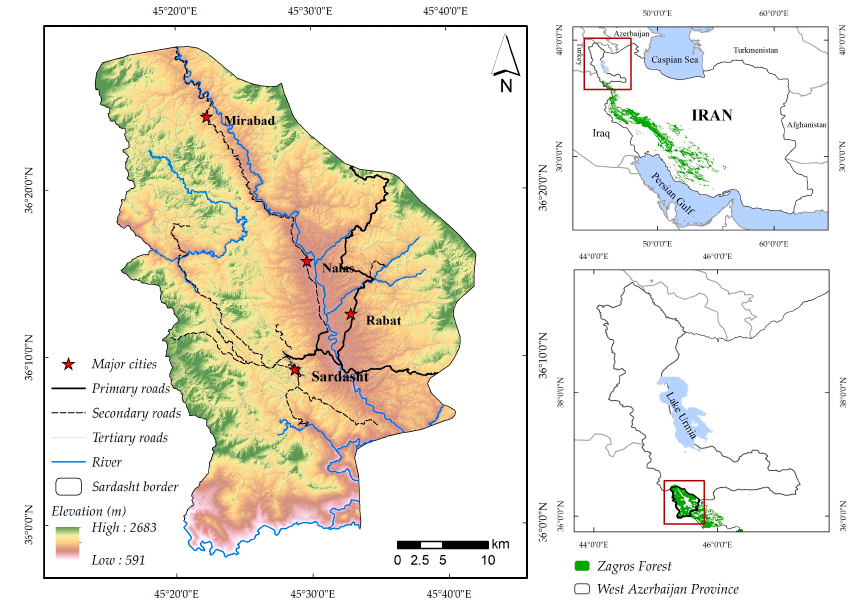
Figure 1. Location of the study area (Sardasht County).